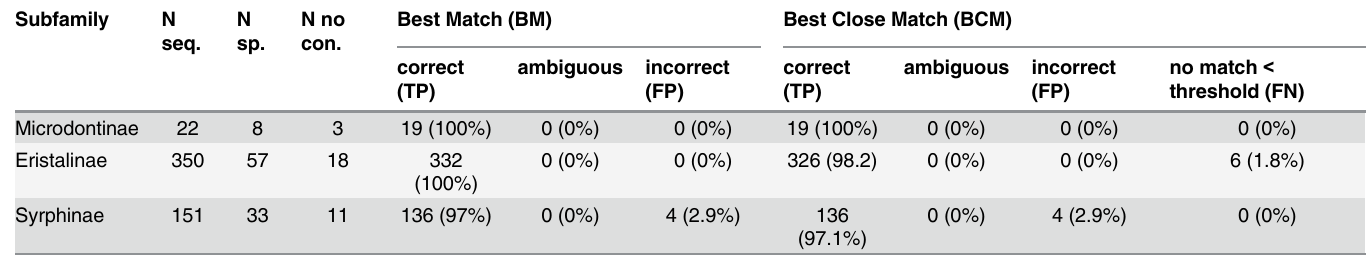
Table 2. Number of sequences (N seq.), number of putative nominal species (N sp.), and the number of putative nominal species for which no con- specific sequence was available in the dataset (N no con.) for the three subfamilies of Syrphidae, and the identification success according to the Best Match (BM) and Best Close Match (BCM) identification methods. TP = true positives, FP = false positives, FN = false negatives. Subfamily N N seq.